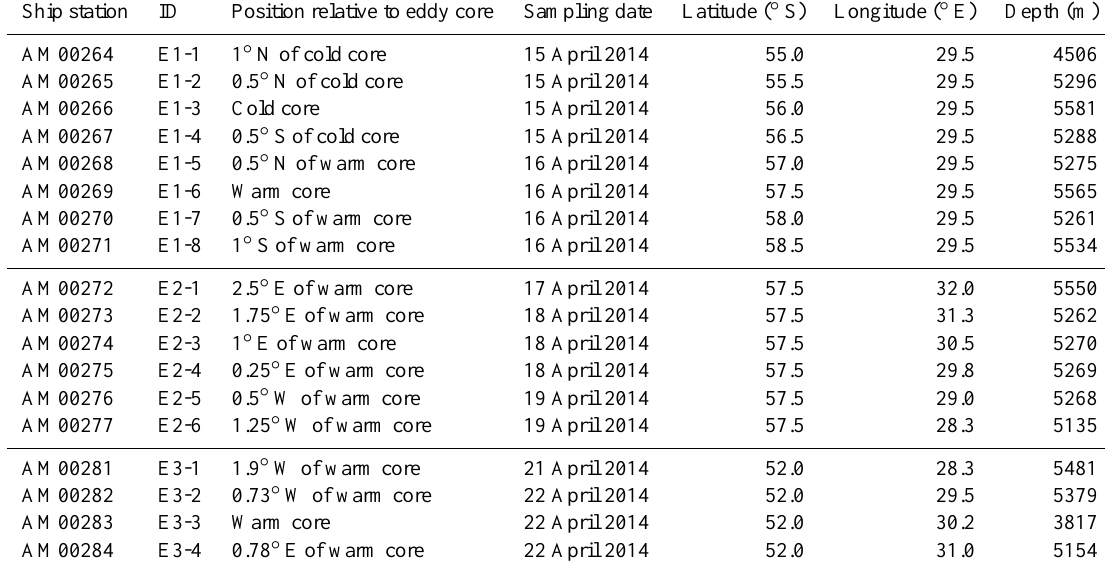
Table 1. CTD station locations and identification of CTD station positions relative to eddy cores, as inferred from altimetry data. E1, E2 and E3 refer to the three transect lines shown in Fig. 1. Based on interpretation of relative SSH anomalies, E1-6 is the core of the older warm-core eddy, E1-3 that of a cold-core eddy and E3-3 that of the young warm-core